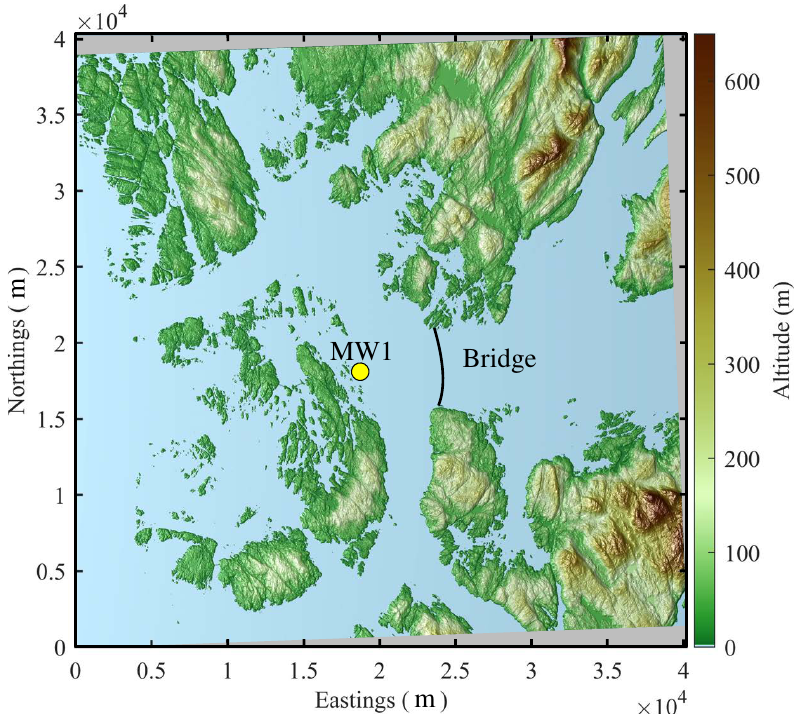
Figure 2. Topography of the Bjørnafjord sketching the future bridge crossing and the mast MW1 used in the analysis of the velocity